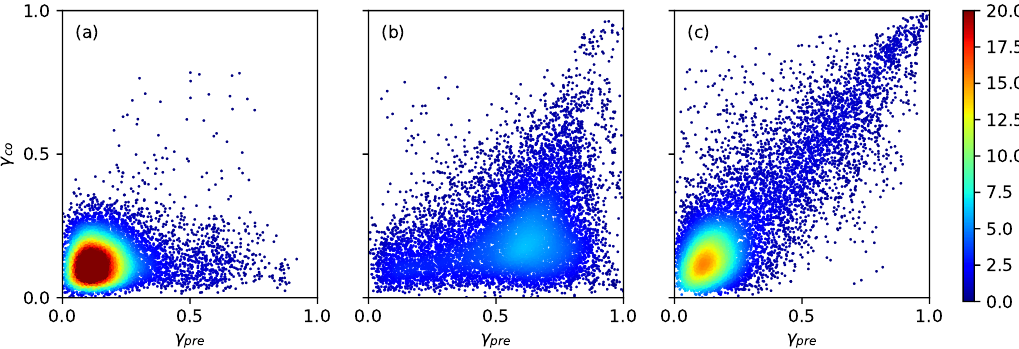
Figure 6. Pre-event ( γ pre ) and co-event ( γ co ) coherence scatter plots computed for ( a ) flooded agricultural areas, ( b ) flooded urban areas, and ( c ) non-flooded agricultural areas. Color marks denote the frequency of occurrence. Each plot consists of 10,000 samples extracted randomly from the polygons depicted in Figure 5b and the surveyed paddy fields (Figure